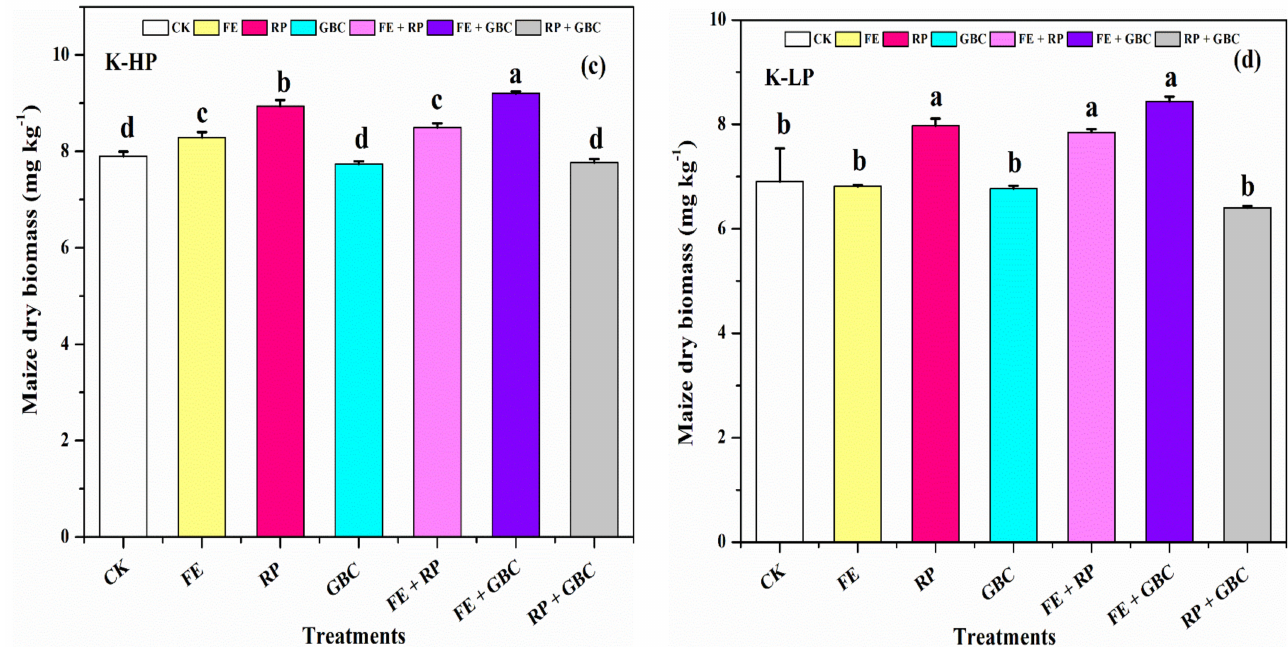
Figure 4. Influence of additives on organic matter ( a ) in K-HP soil, ( b ) H-LP soil; dry biomass ( c ) in K-HP soil, and ( d ) in H-LP soil. The values in a given column followed by the same letter are statistically not significantly ( p < 0.05) using Tukey’s HSD